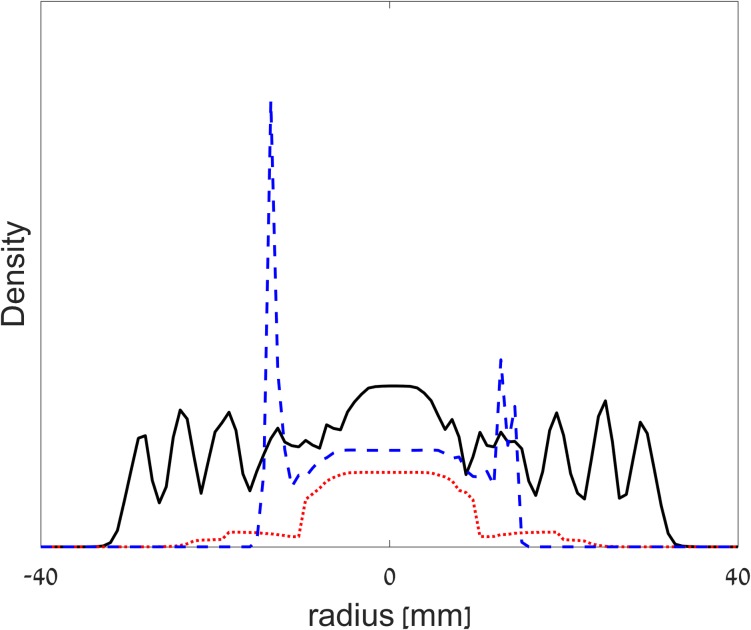
A snapshot of the simulated cross-sections of the different colonies: P. vortex and E. coli (solid black line), only P. vortex (dotted red) and only E. coli (dashed blue).